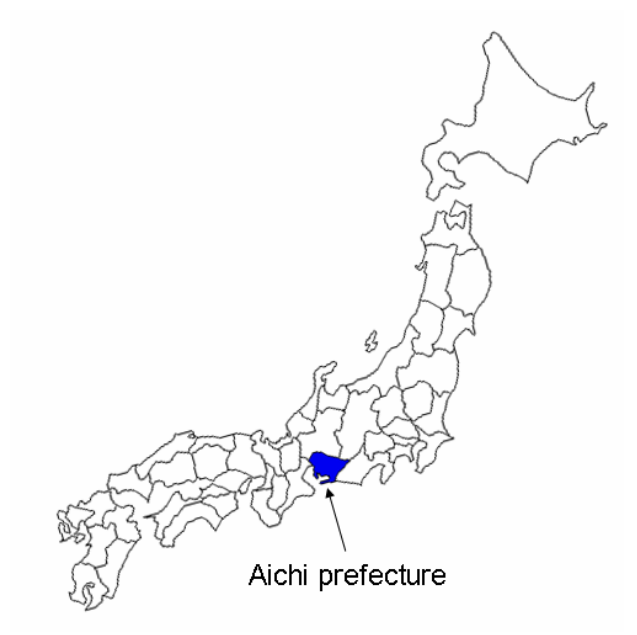
Figure 2. Location of Aichi Prefecture within Japan